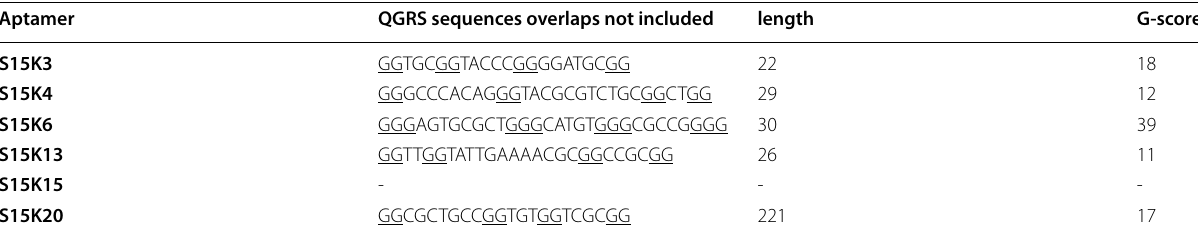
Table 2 QGRS sequences Aptamer QGRS sequences overlaps not